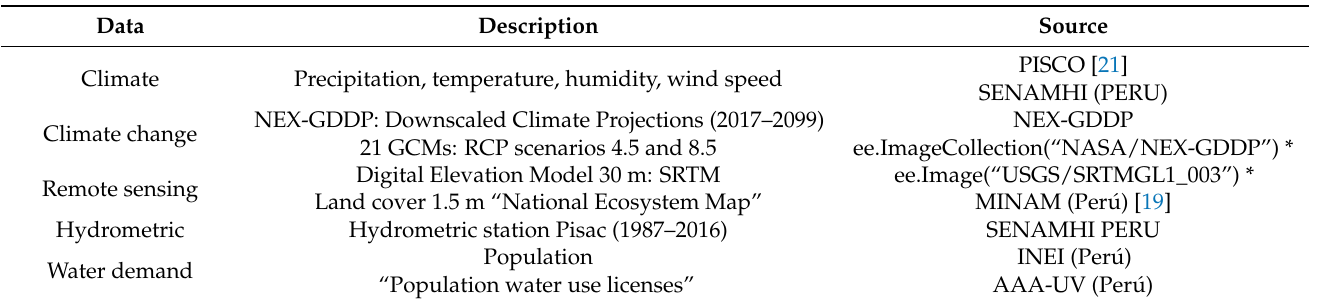
Table 2. Sources for the data